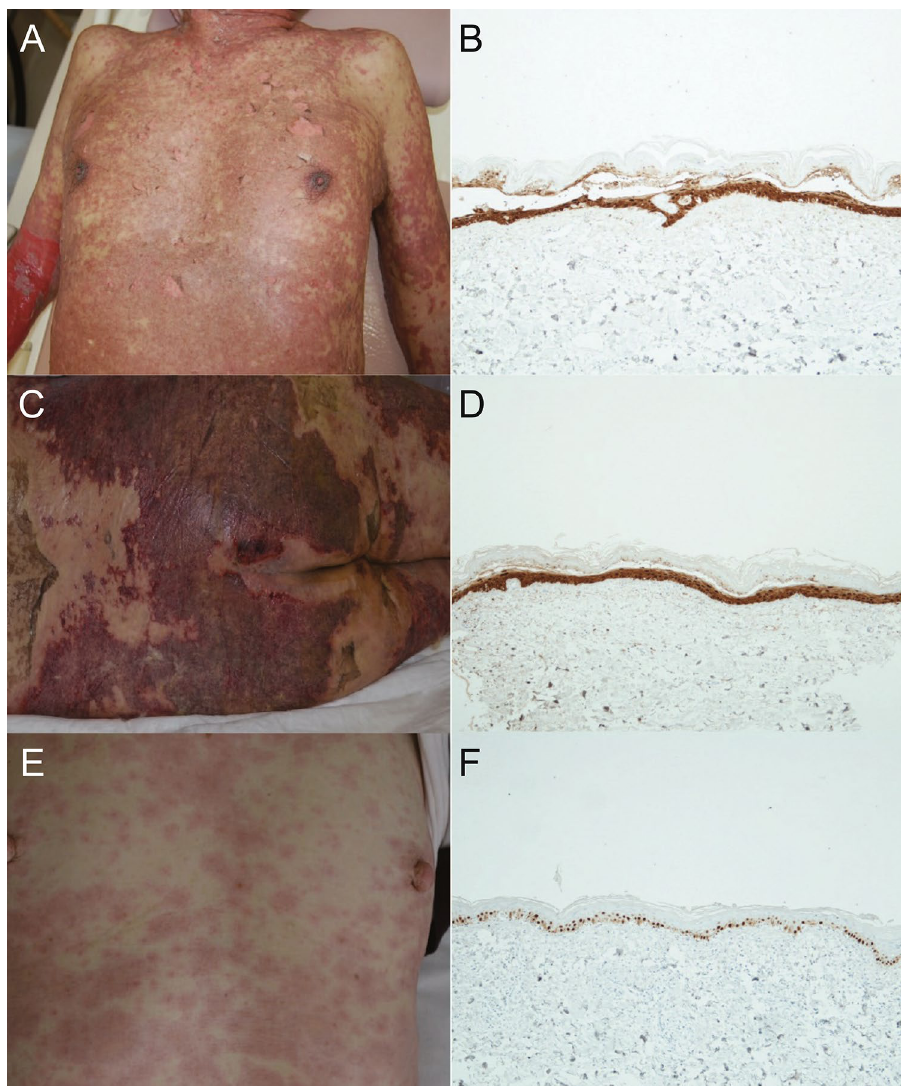
Figure 3. S100A2 expression in the epidermis of patients with drug eruption and clinical manifestations. ( A ) Clinical manifestation of a patient with toxic epidermal necrolysis after exposure to celecoxib and ( B ) the expression of S100A2 in the epidermis. ( C ) Clinical manifestation of a patient with toxic epidermal necrolysis in response to phenytoin and ( D ) the expression of S100A2 in the epidermis. ( E ) Clinical manifestation of a patient with macular-type drug eruption after celecoxib treatment and ( F ) the expression of S100A2 in the epidermis.